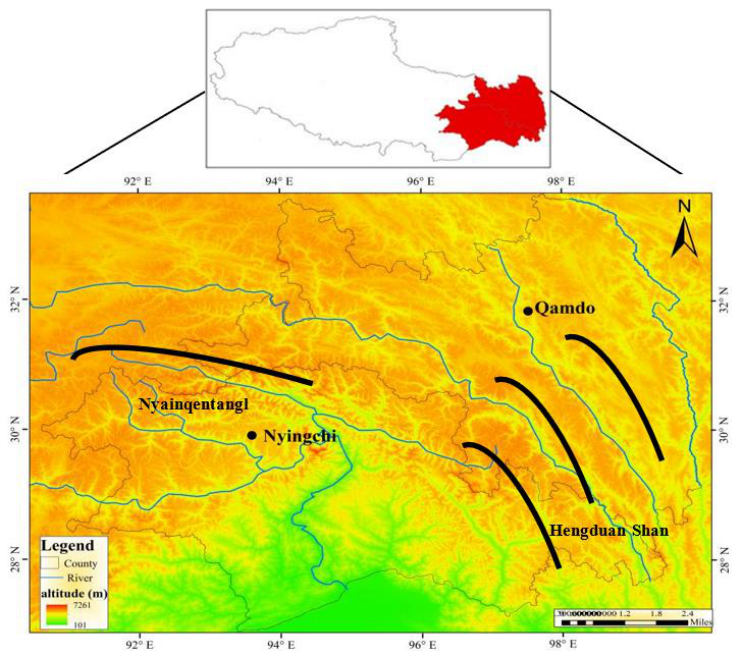
Figure 1. Schematic map of southeastern Tibet.